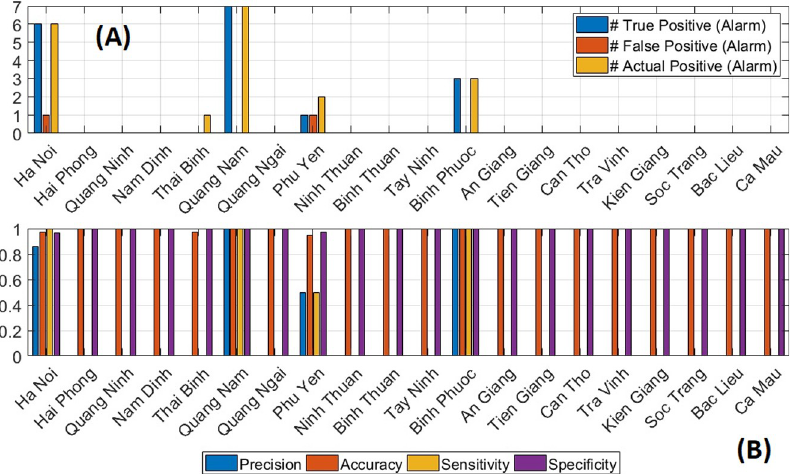
Fig 6. Outbreak detection by LSTM-ATT. Numbers of actual outbreak months, correct outbreak month predictions (true positive) and incorrect outbreak month predictions (false positive) for each province are shown (Fig 6A). Additionally, prediction metrics (precision, accuracy, sensitivity, and specificity) for each province are displayed (Fig 6B). If a province did not have any actual epidemic months in the evaluation period, the precision and sensitivity are not available. LSTM-ATT = attention mechanism-enhanced